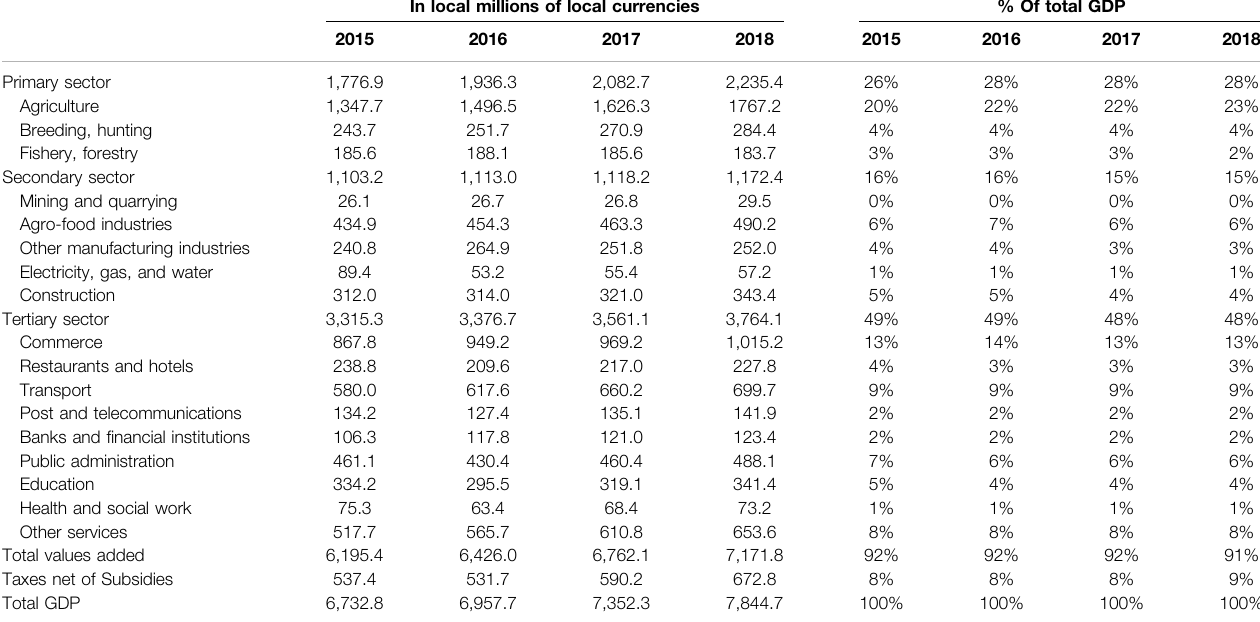
TABLE 1 | Decomposition of the factor contributing to the gross domestic product. In local millions of local currencies